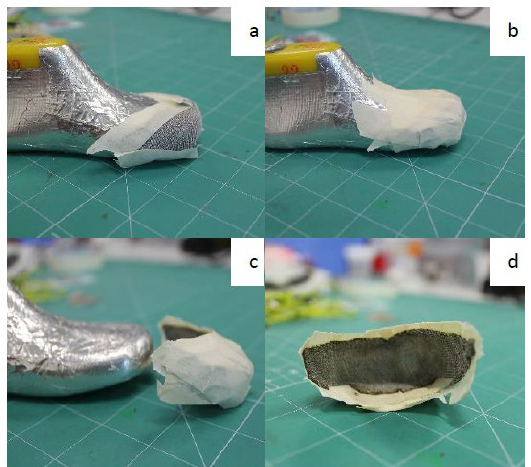
Figure 6. Example of the fabric sensors installed using 80/20 PES/SS sample. ( a – c ) low tack masking tape is used to shape the fabric sensor insulating the other layer. ( d ) completed sensor to go inside the toe area of the shoe.